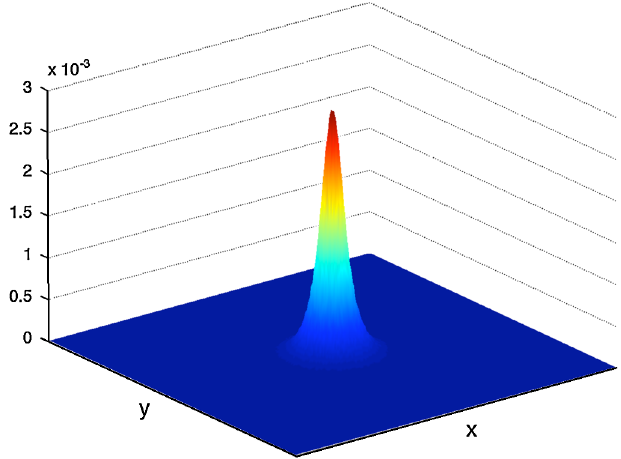
RR a ð x; y Þj 2 dxdy ¼ 1 ) intensity of 3. (Color) Normalized ( j light at the exit of the Brookhaven SDL undulator. Intensity in arbitrary units. Transverse dimension in dimensionless units is (cid:1) 3 : 16 (cid:7) x (cid:7) 3 : 16 and the same for y FIG. 4. (Color) Histogram of coefficients contained in the field at the exit of the Brookhaven proposed undulator. The normal- ized j C m;n j 2 shows 95% of the mode’s power is in the (0,0) mode. The (2,2), (4,0), and (0,4) modes contain approximately 1% of the power each. No other mode contains more than 1% power through the (7,7)